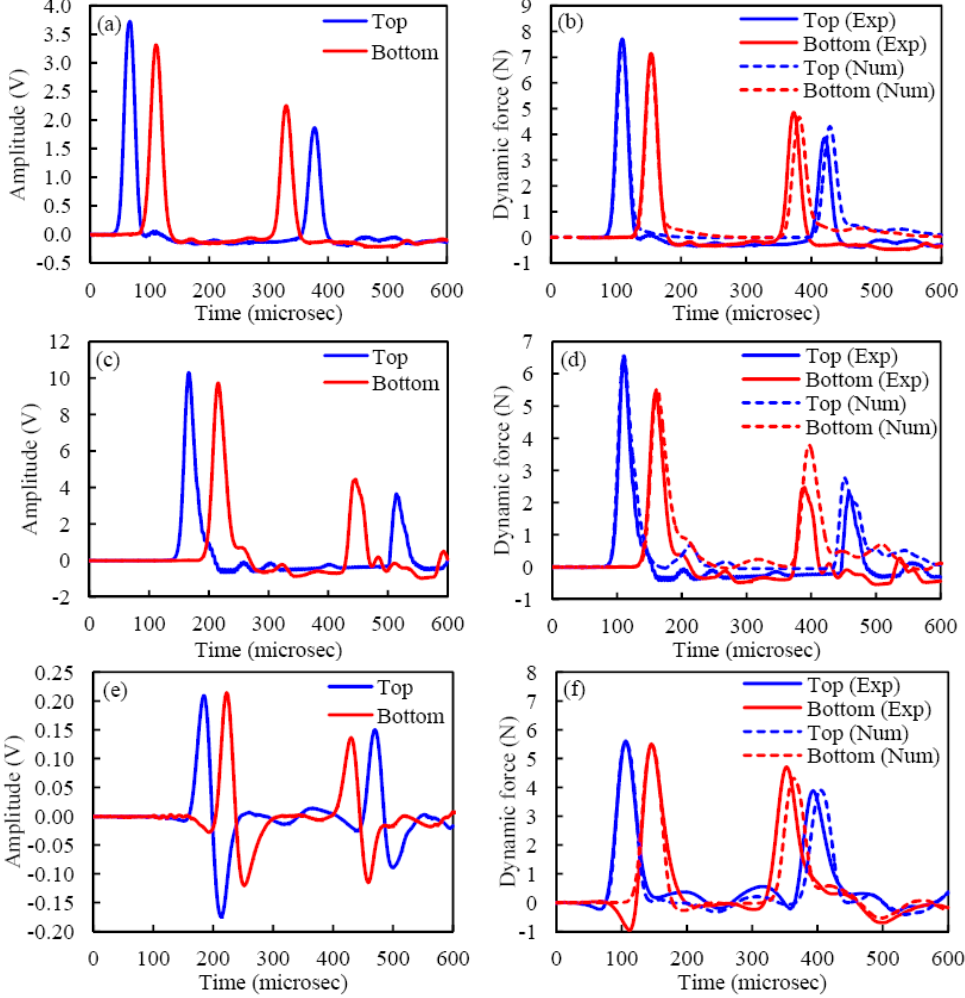
Figure 7. ( a ) Experimental results for bead sensors, ( b ) comparison of experimental and numerical results for bead sensors, ( c ) experimental results for cylindrical sensors, ( d ) comparison of experimental and numerical results for cylindrical sensors, ( e ) experimental results formagnetostrictive sensors, ( f ) comparison of experimental and numerical results for magnetostrictive sensors.